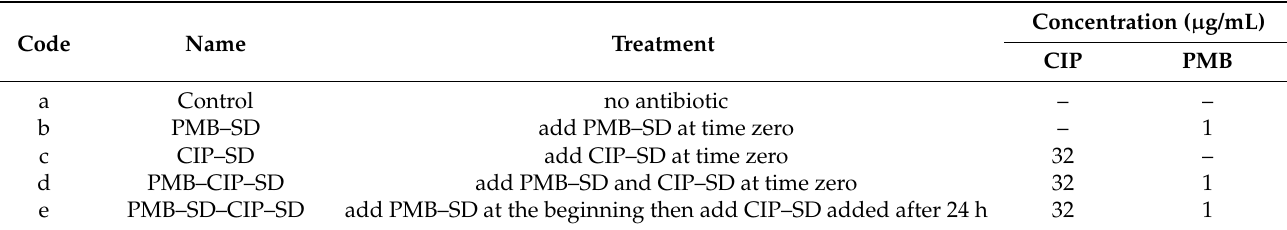
Table 3. Group setting and corresponding antibiotic addition